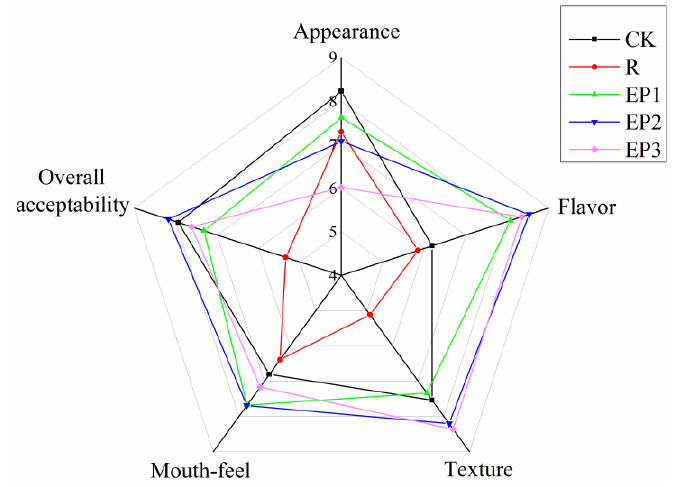
Figure 2. Sensory properties of pork